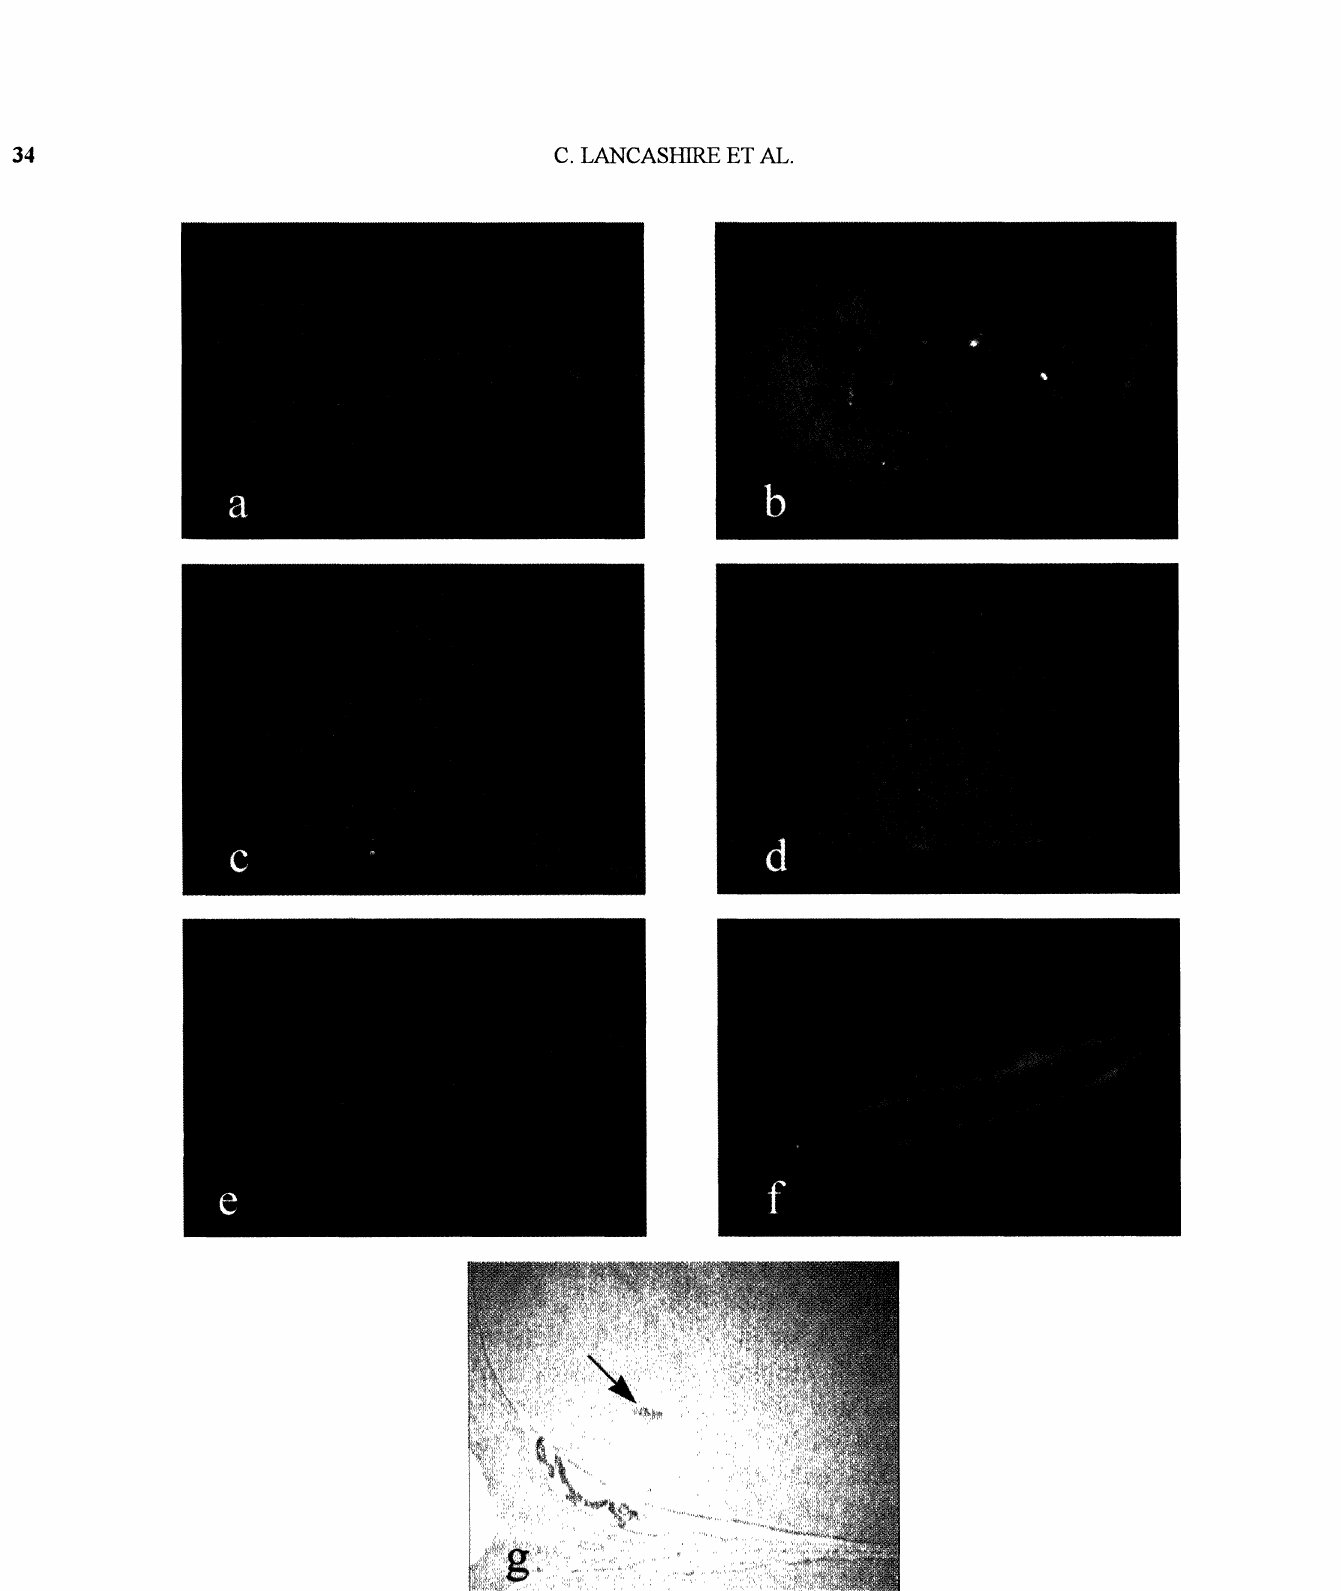
Fig. 2:Immunocytochemistry of anti-ApoE and anti-Apo-A-I localization at 10 min post-injection. One-day-old chicks were injected bilaterally into the IMHV with anti-ApoE (a,c,e) and anti-ApoA-I (b,d,f). Ten min later, the chicks were killed, brain tissue frozen, and immunocytochemistry carried out on 15 tm coronal sections as described in the Experimental section. Texas Red conjugated anti-mouse IgG was used to locate the injected anti-ApoE and Fluorescein-conjugated anti- rabbit IgG to locate the anti-ApoA. Sections (a-f) were examined on a Leica confocal microscope (xl00). Toluidine blue counterstained sections (g) were examined on a Zeiss Axiophot (x25). Figures show coronal sections through the forebrain in the region of A 8.8 (Kuenzel & Masson, 1988). Sections a-b: injection site; c-d: Neuropil; e-f: Ventricles; g: Toluidine blue counterstaining, arrow indicates the injection